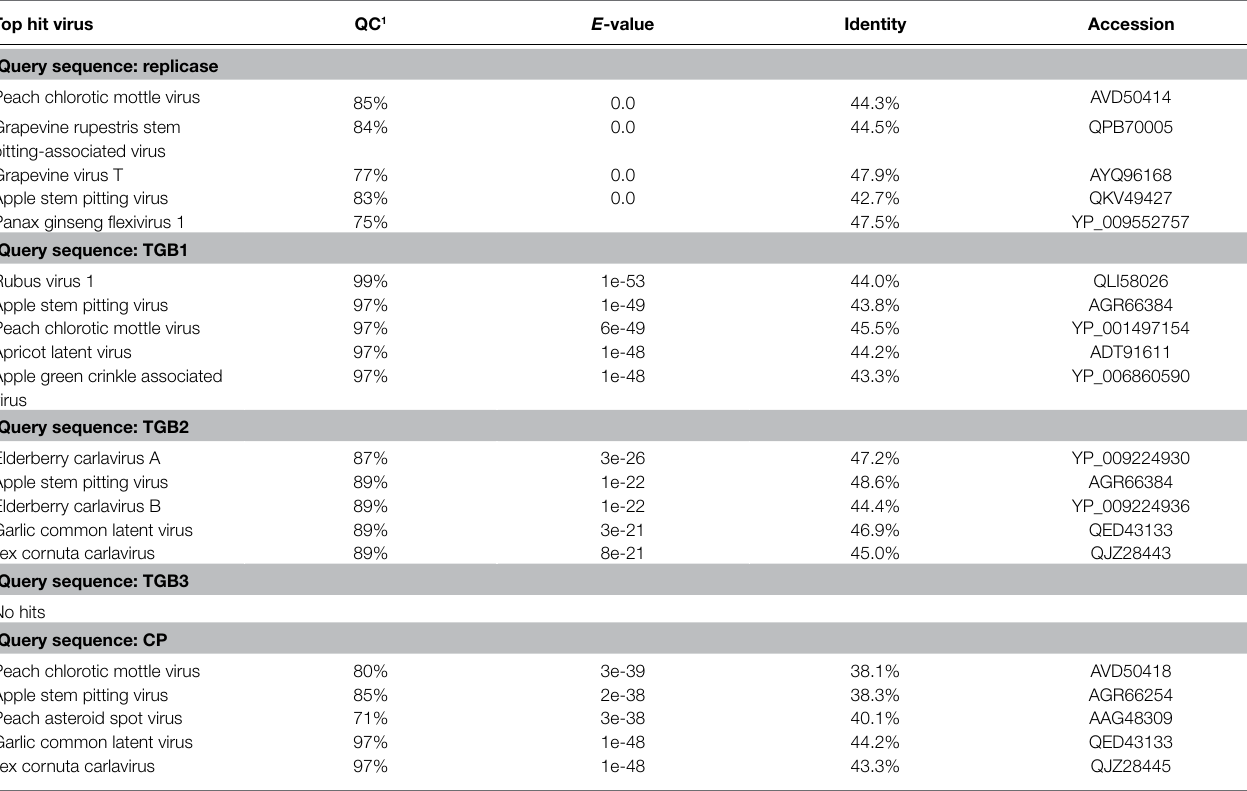
TABLE 4 | BLAST-P analyses using viral proteins of WVQ (strain a) as the queries.